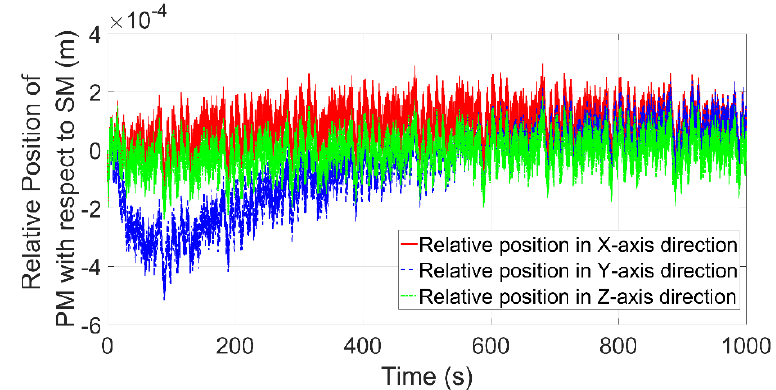
Figure 5. Centroid position of the PM with respect to the SM. PM, payload module; SM, support module.